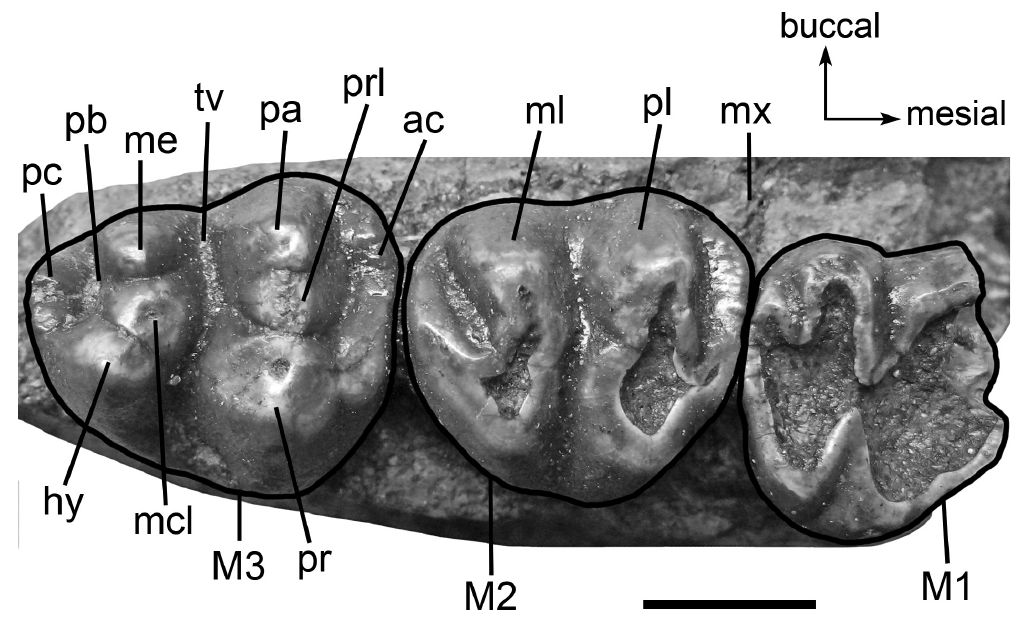
Fig. 8. The right upper molars M1–M3 of Lentiarenium cristolii ( Fitzinger, 1842) (OLL 1926/394) in occlusal view. Scale bar = 1